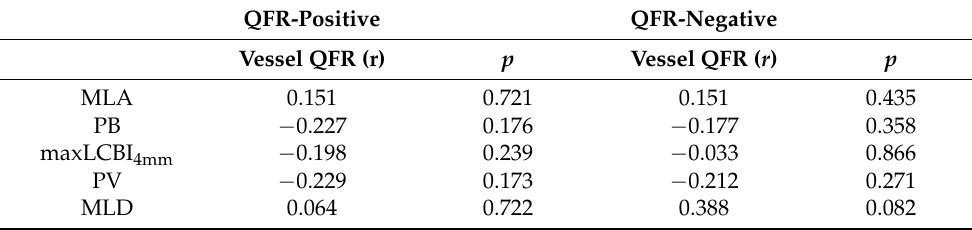
Table 3: maxLCBI 4mm —maximal lipid core burden index in 4 mm; MLA—minimal lumen area; MLD—minimal lumen diameter; PB—plaque burden; PV—plaque